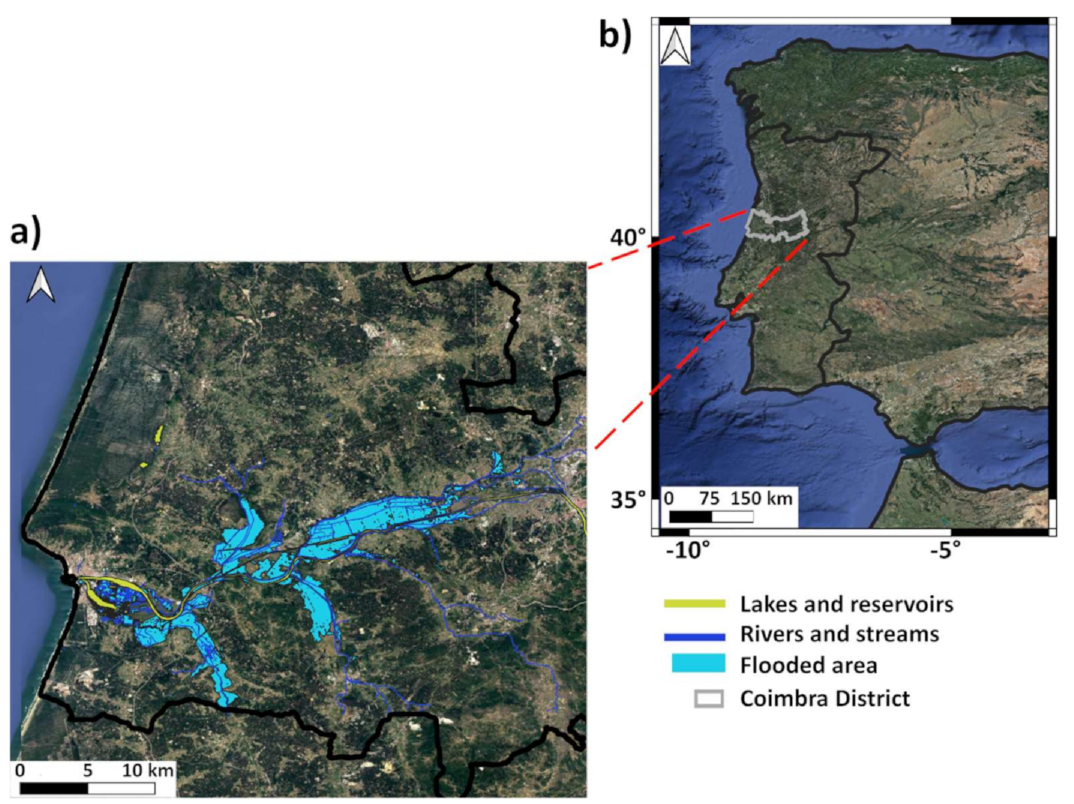
Figure 8. Floods area and dike breaches occurred in Coimbra—Mondego River Basin. The map ( a ) shows the flood event delineation in the area of Coimbra District (Portugal) on 23 December 2019. The location of Coimbra District in Portugal ( b ). Vector data obtained from